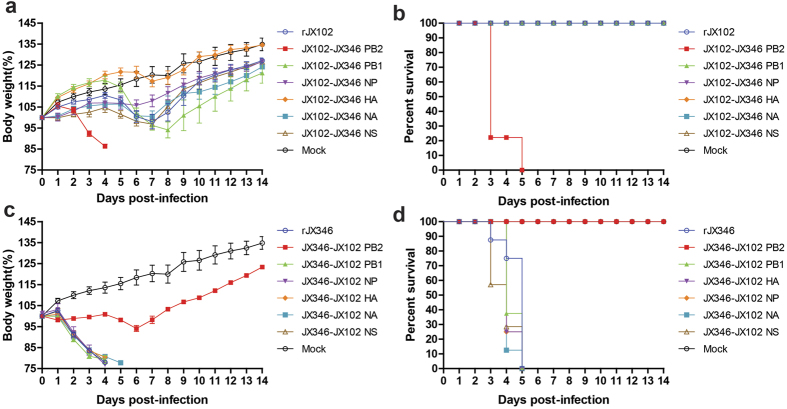
Pathogenicity of the H10N8 recombinant viruses in mice.Eight mice per group were intranasally inoculated with 106 EID50 (in 50 μl) of the indicated viruses (or treated with PBS as a control). Body weight (a,c) and survival rate (b,d) was monitored daily for 14 days. Mice that lost more than 25% of their initial weight were euthanized. The percentage weight from each group and each time point are presented as means ± SD.